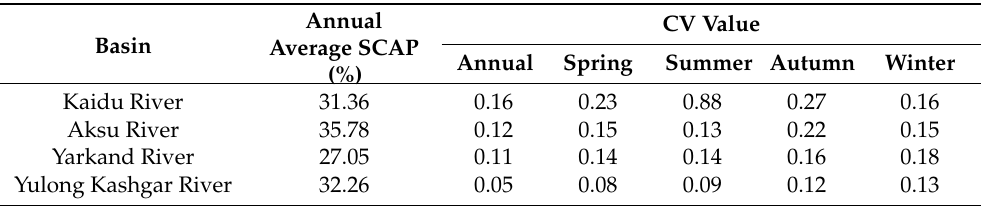
Table 3. Characteristics of annual and seasonal SCAP in four typical river basins in the